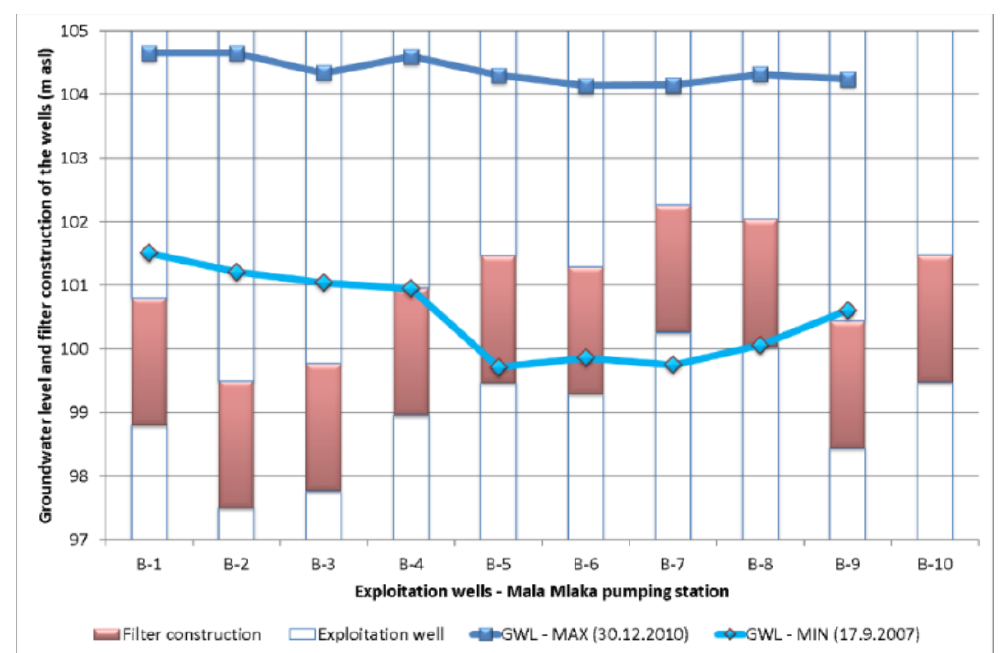
Figure 10. Minimum and maximum groundwater levels and filter construction of exploitation wells at the Mala Mlaka water pumping